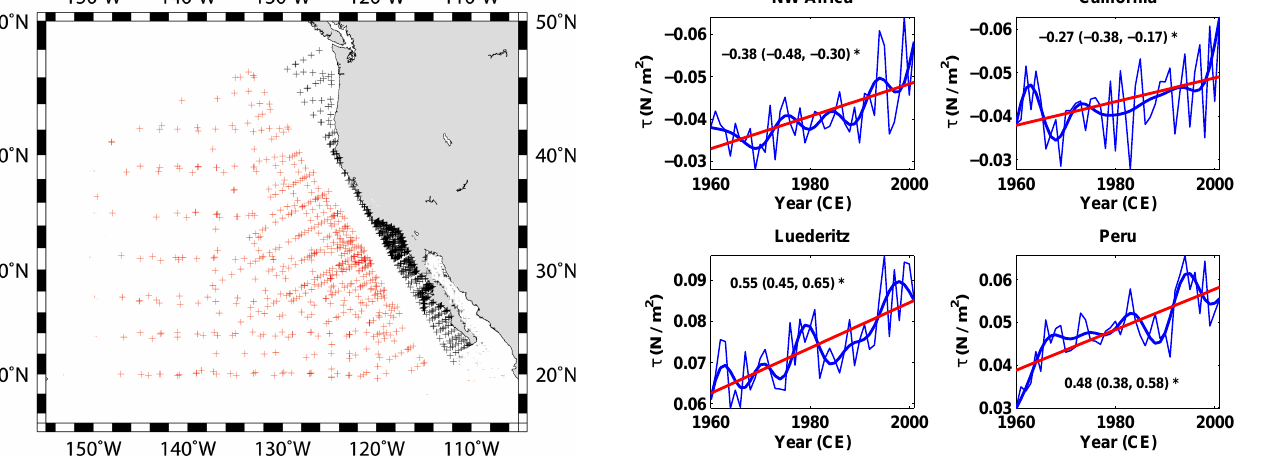
Fig. 2. CALCOFI (Bograd et al., 2003) data used to calculate the SST index. It is calculated by subtracting the area-averaged SST over coastal locations (black) from the area-averaged SST of the offshore locations (red).